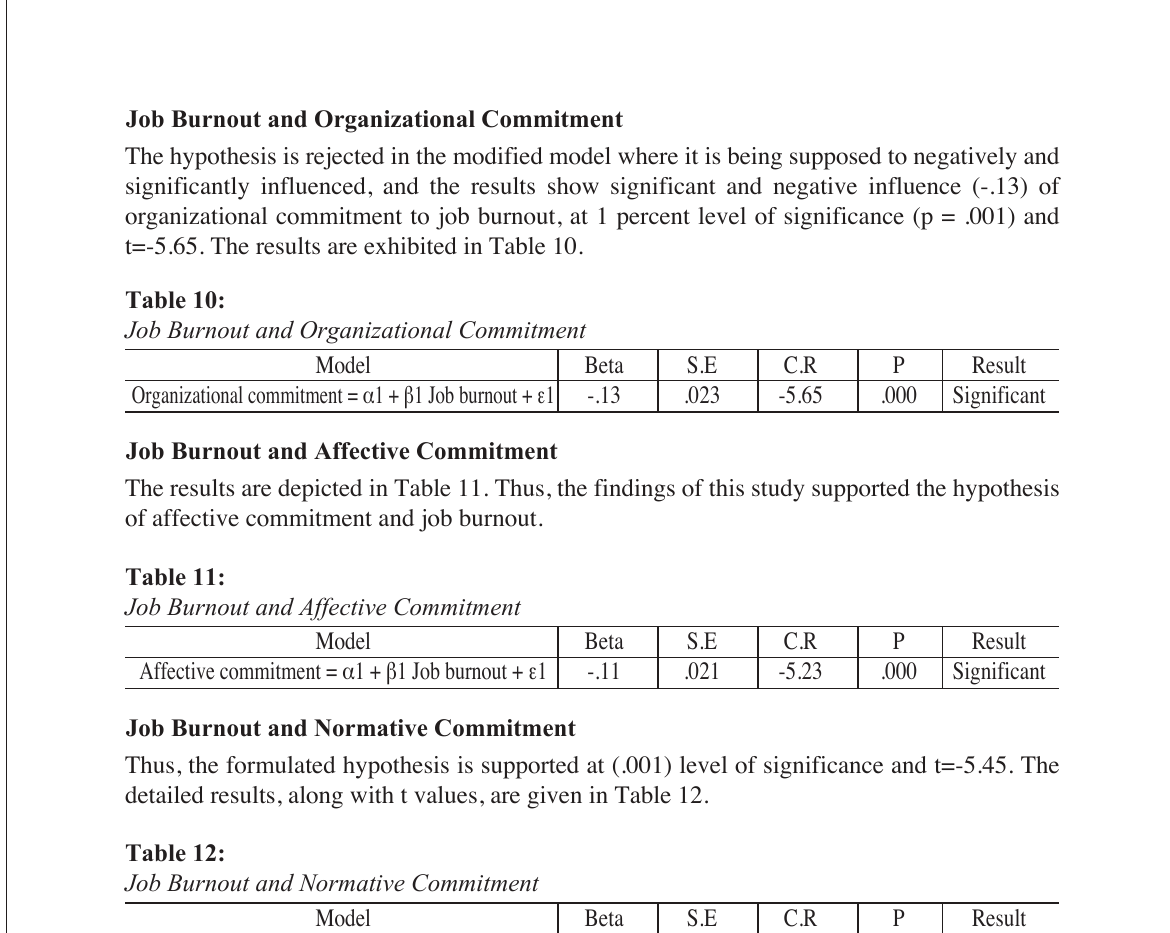
Job Burnout and Organizational Commitment